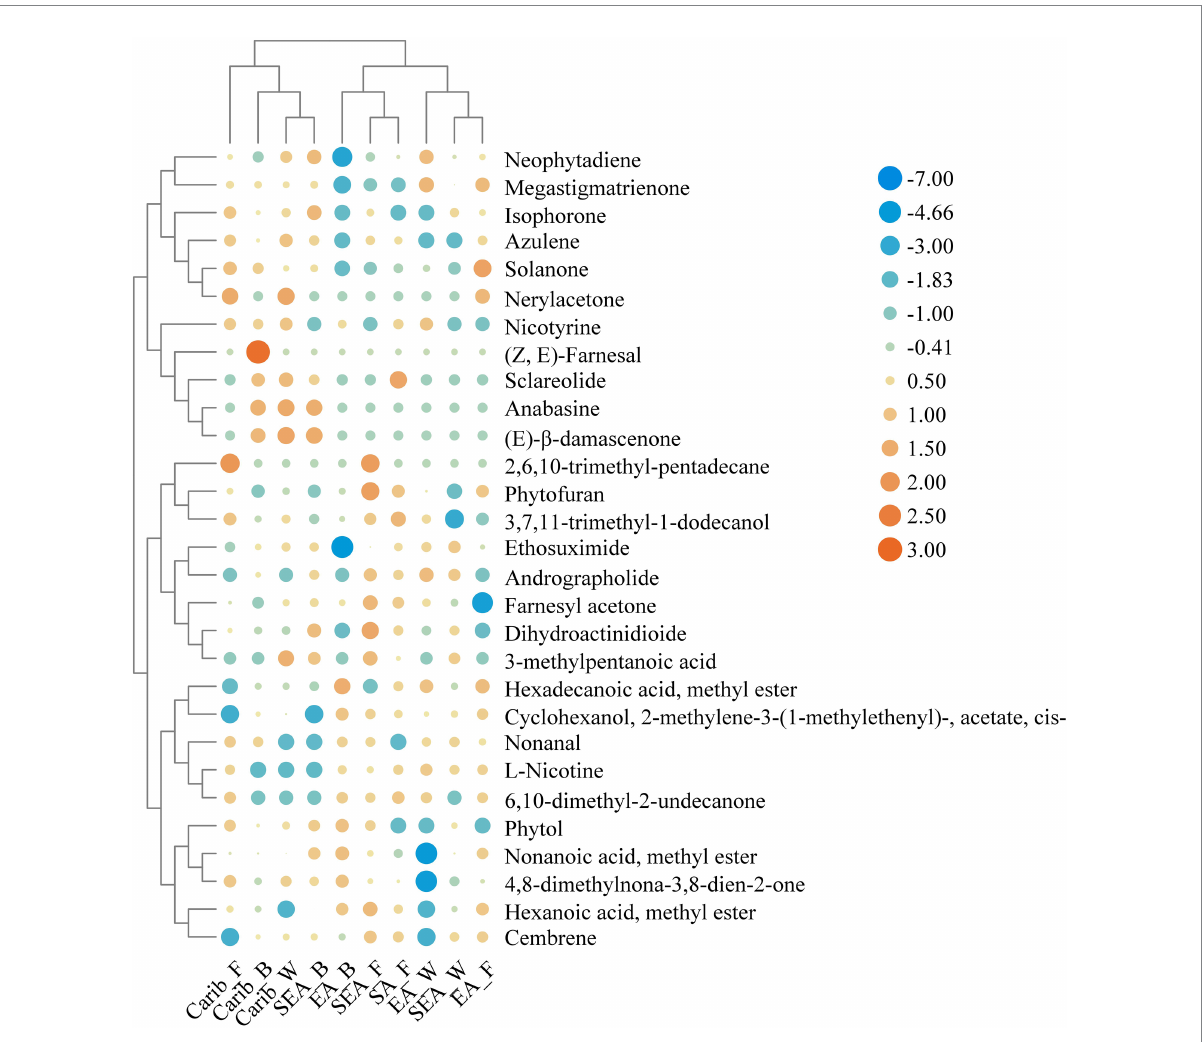
FIGURE 8 Heatmap of typical volatile metabolites in the cigar